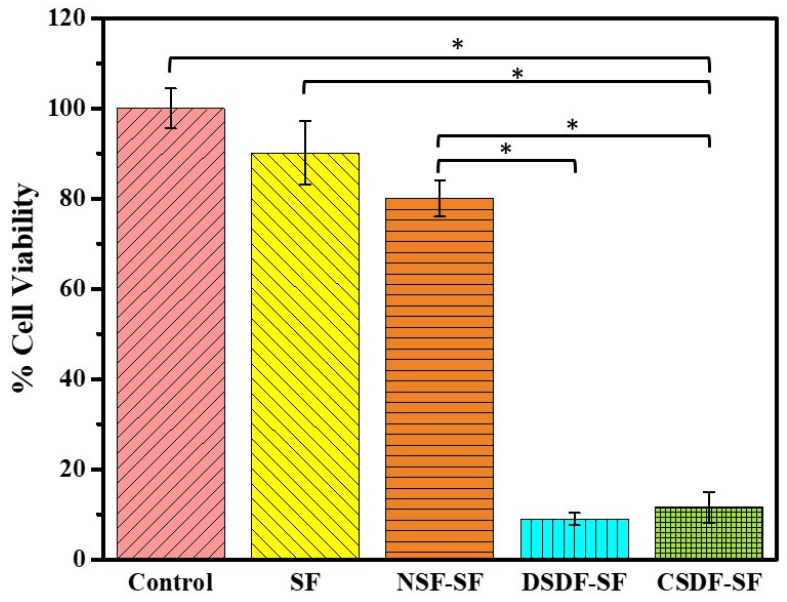
Figure 7. The cell viability of the extracted materials, examined through the MTT assay (* depicts p -value < 0.05).